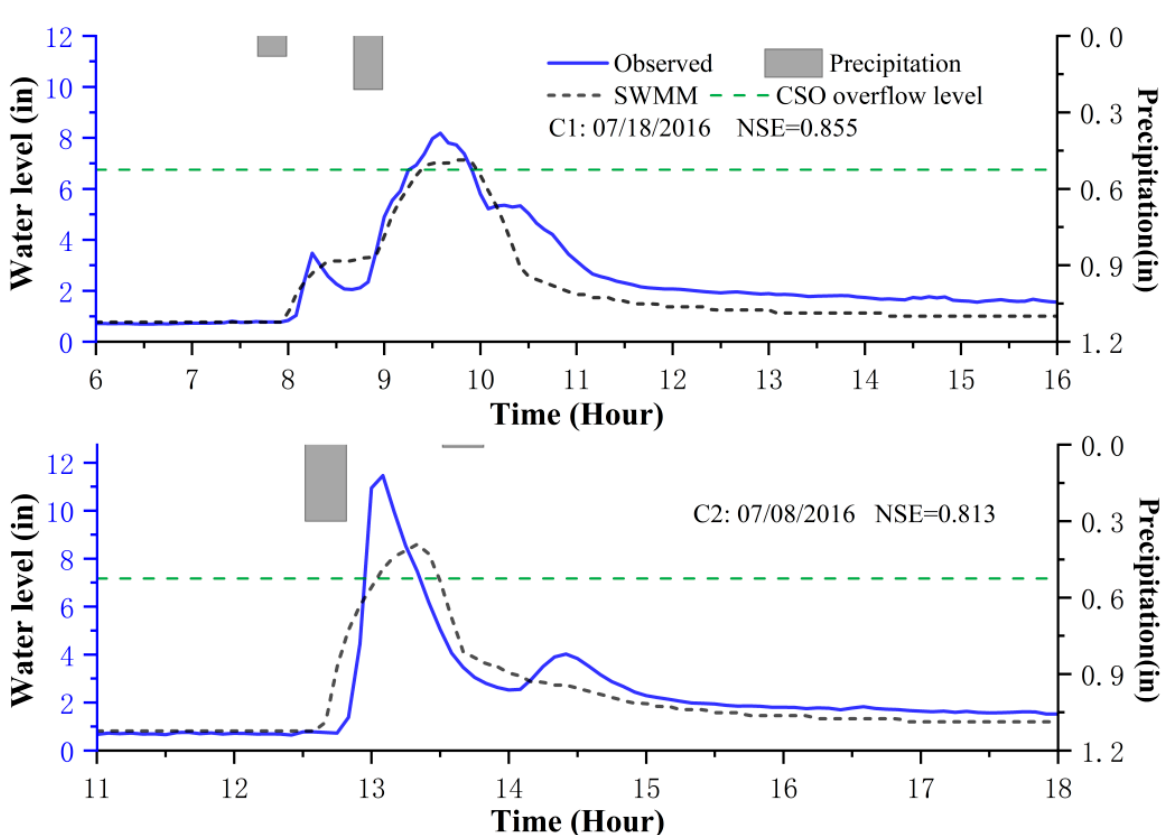
Figure A1. Model calibration.